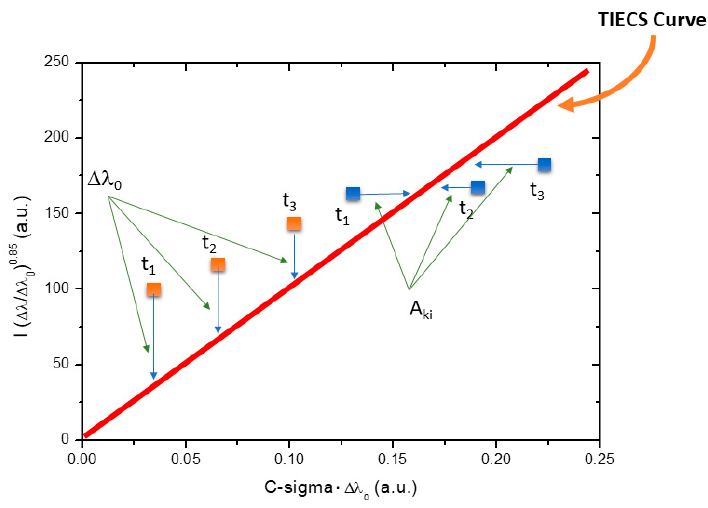
Figure 7. Determination of Δ λ 0 or A ki from the TIECS curve.